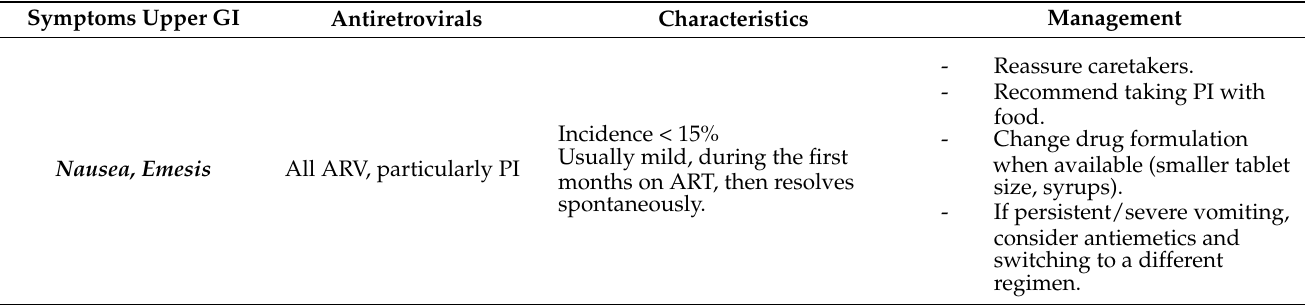
Table 1. Gastrointestinal adverse events associated with antiretroviral